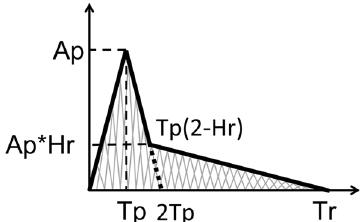
Fig. 4 A Kostrov-type triangular STF (after Graves and Pitarka 2004) used in this